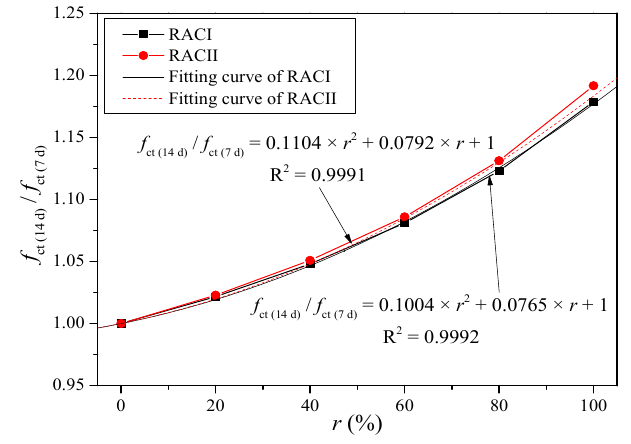
Figure 10. Fitting curve of coefficient γ 14d.